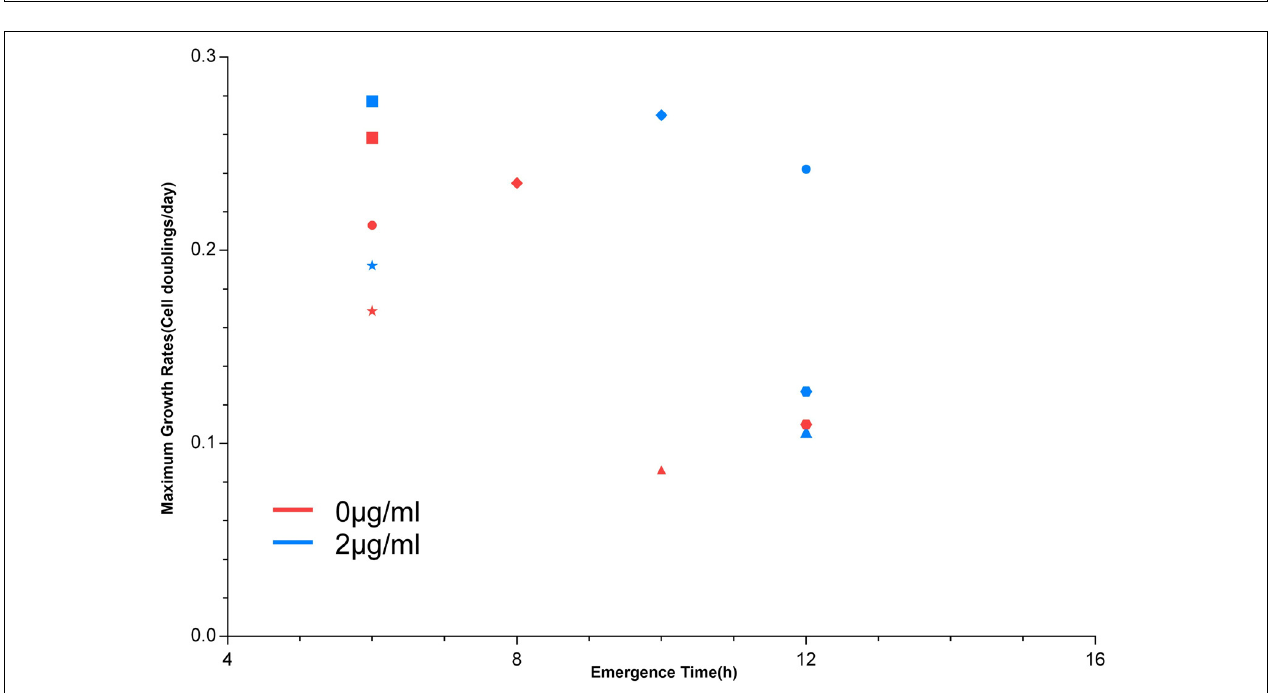
FIGURE 2 | Maximum growth rates of 41 S. aureus . The maximum growth rates of strains in 0 and 2 µ g/ml vancomycin treatments were sorted and compared.